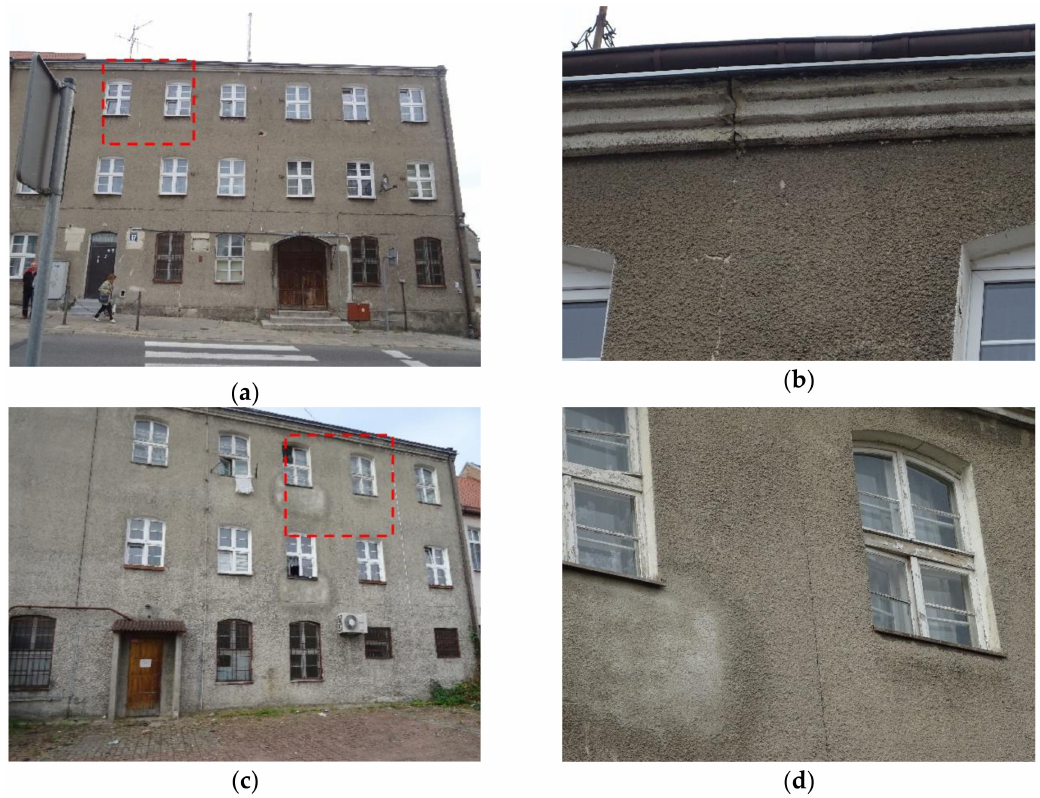
Figure 3. Damaged facade: ( a ) front; ( b ) zoom on crack in the front; ( c ) back; ( d ) zoom on the crack in the